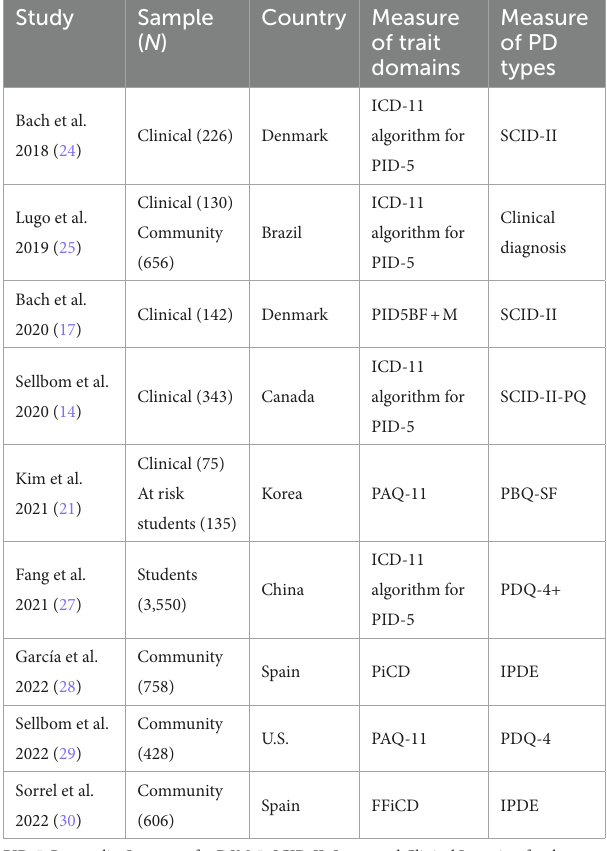
TABLE 1 Characteristics of seven studies reporting correlations between personality disorder types and ICD-11 trait domains.